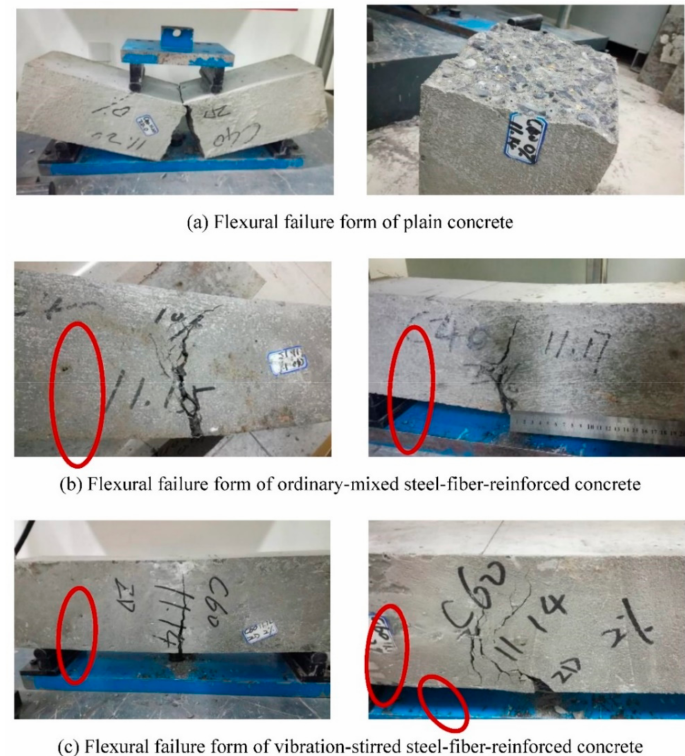
Figure 11. Concrete flexural failure forms. Flexural failure form of plain ( a ), Flexural failure form of ordinary-mixed steel-fiber-reinforced concrete ( b ), and Flexural failure form of vibration-stirred steel-fiber-reinforced concrete ( c ).